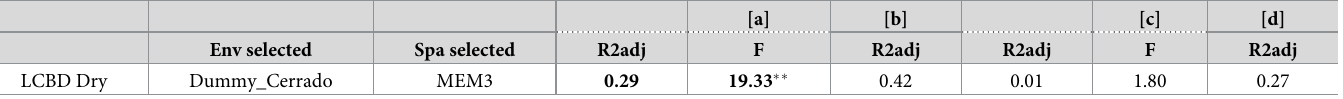
Table 1. Results of the partial redundancy analysis of site uniqueness for anurans during the dry season, where [a] pure environmental component, [b] the amount of var- iation shared by environmental component and spatial component, [c] pure specific spatial component and [d] non-explained variation (residual). [a] [b] [c] [d] Env selected Spa selected R2adj F R2adj